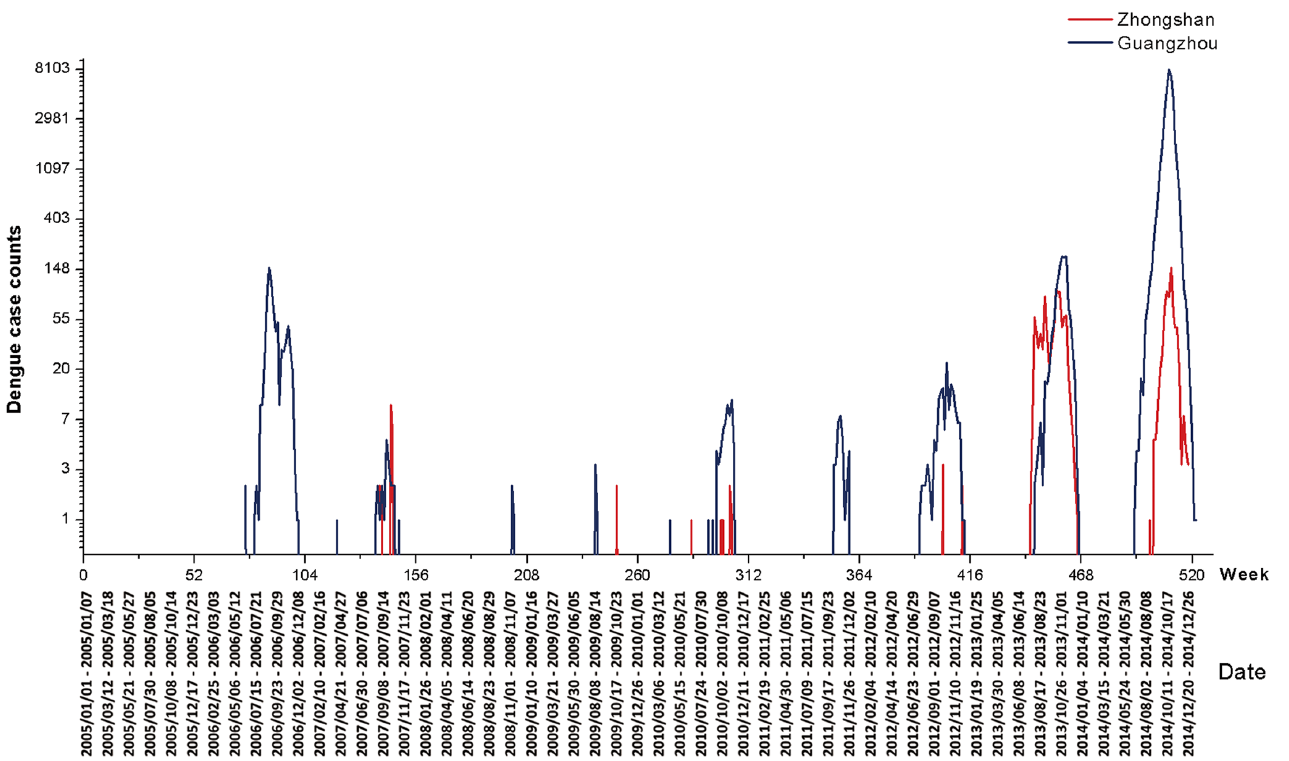
Fig 2. Weekly dengue case numbers in Zhongshan and Guangzhou, 2005 to 2014. * * : The Y axis is displayed in natural exponential scale.